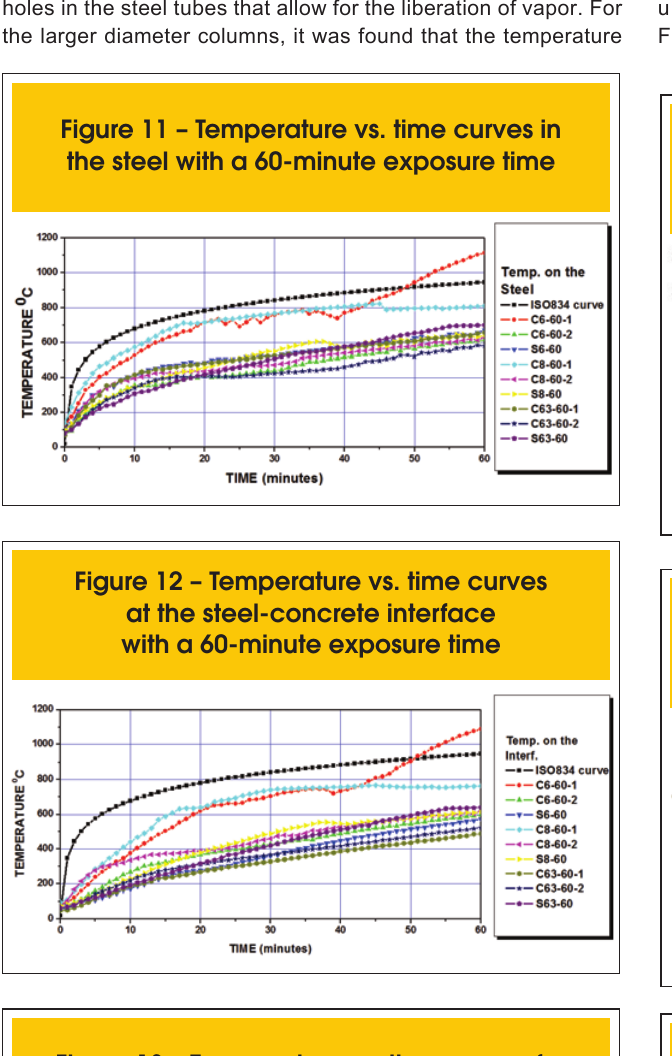
Figure 13 – Temperature vs. time curves for the concrete with a 60-minute exposure